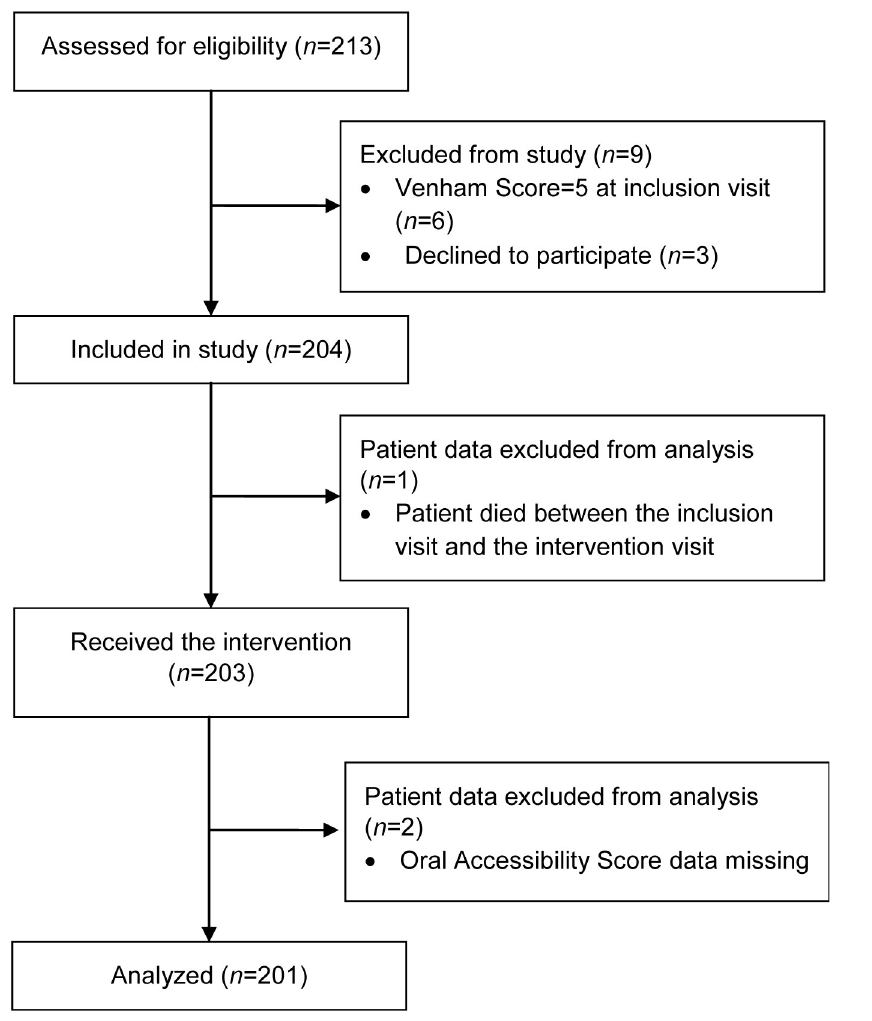
Fig 2. Flowchart of patient disposition during the